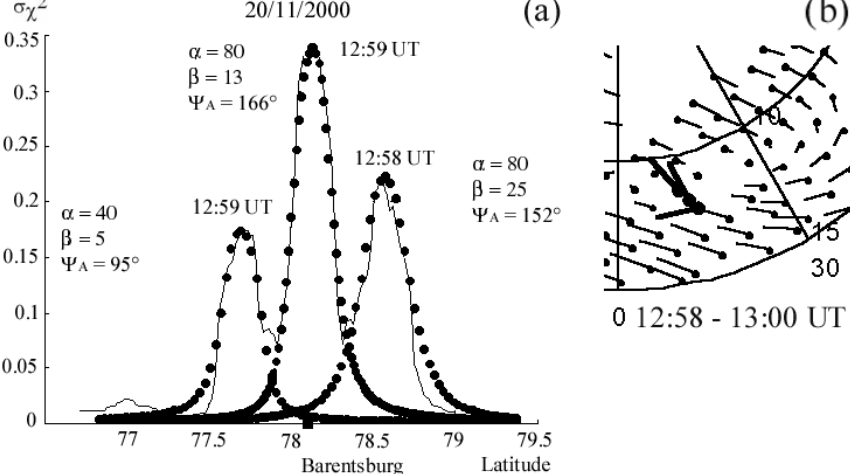
Fig. 4. The same as in Fig. 1 but for the case of 20 November